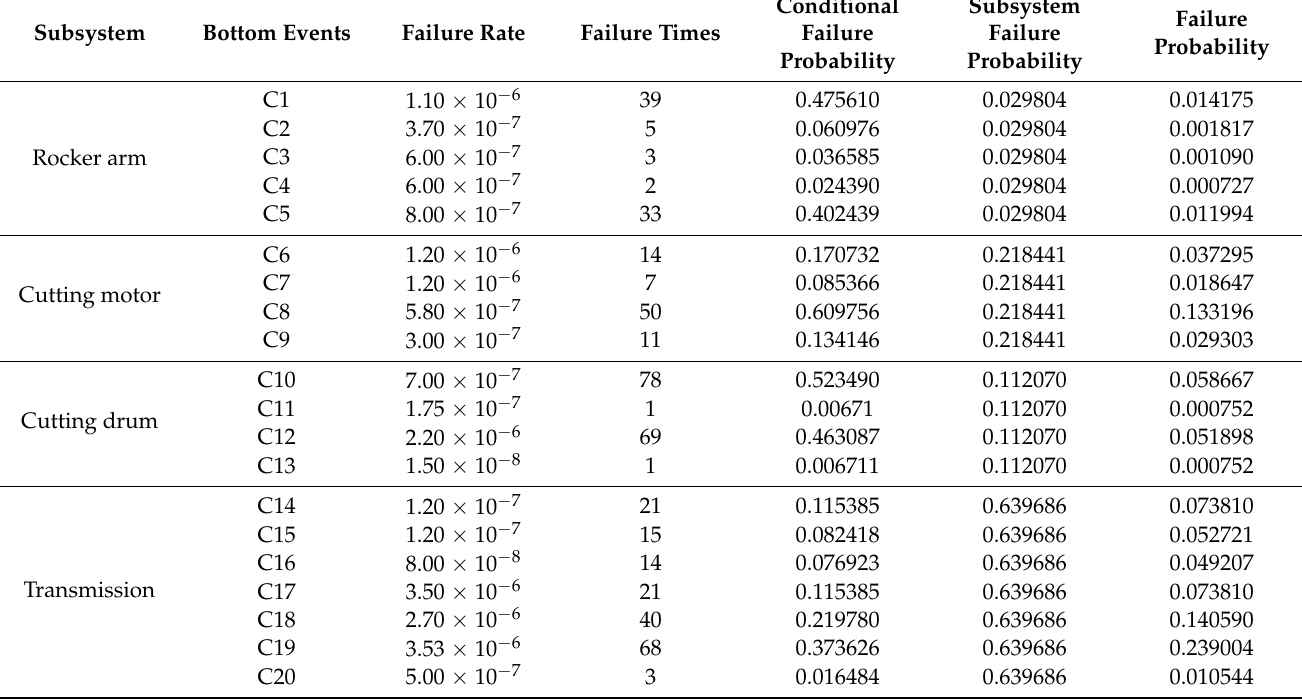
Table 4. The probability of failure of each fault event in the interception department.